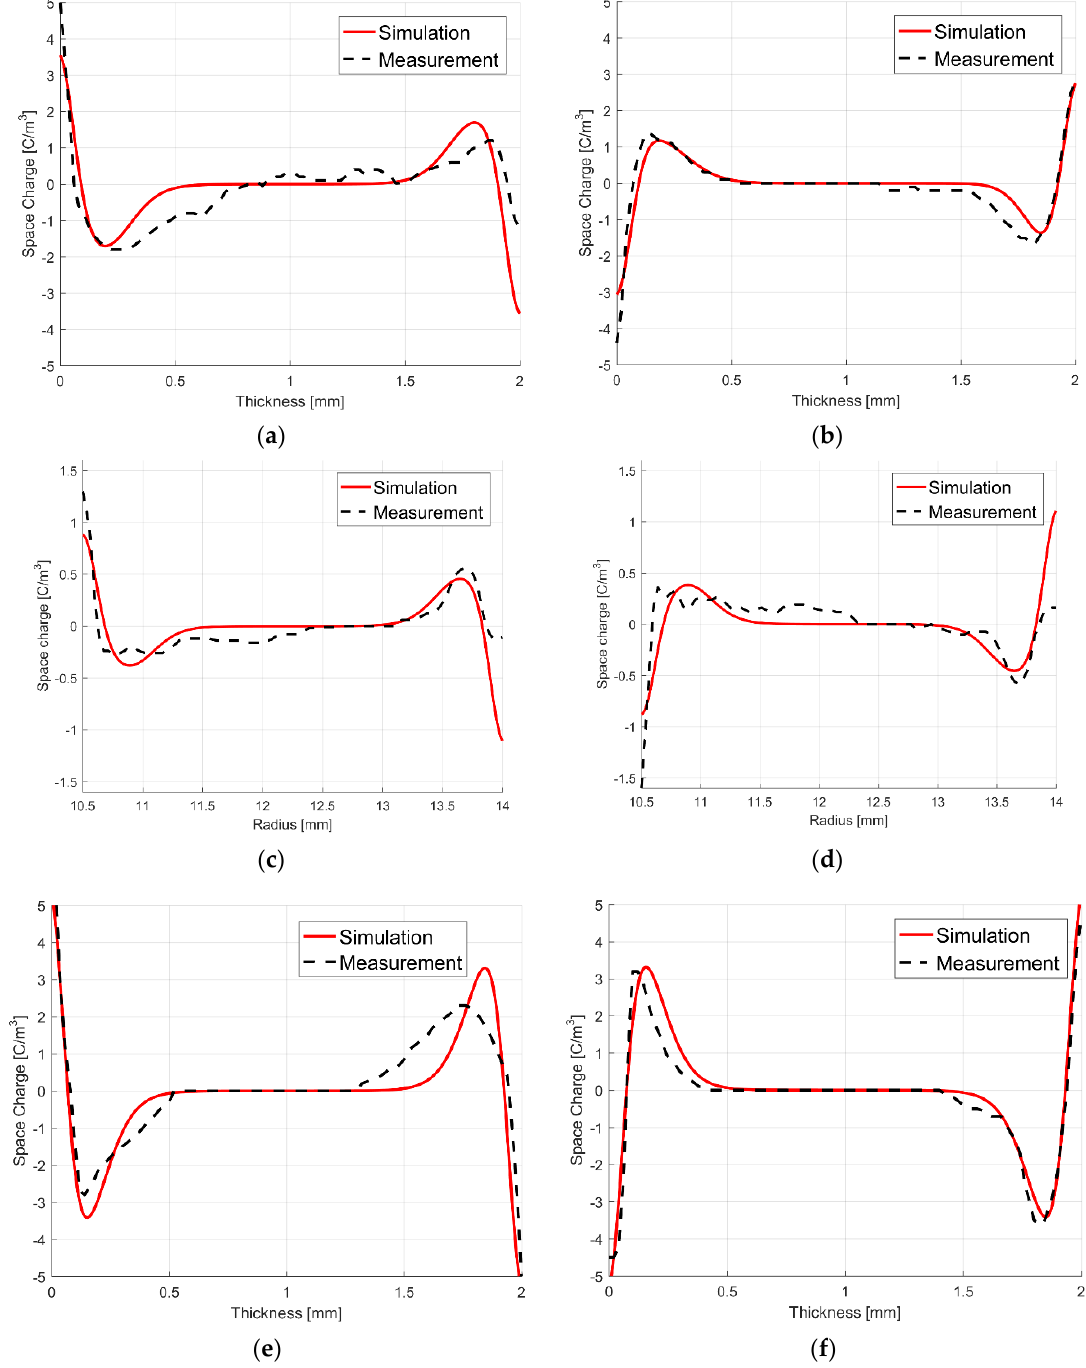
Figure 18. Measured and simulated charge distribution in a XLPE and a LDPE insulation [91]. ( a ) XLPE,